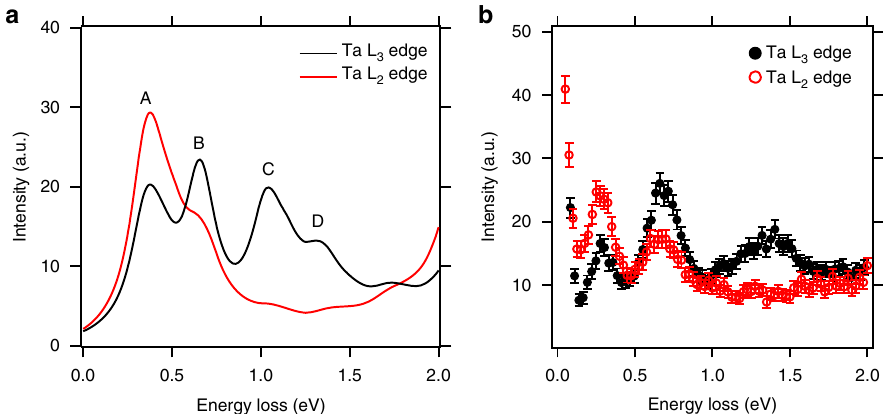
Fig. 5 Cluster model calculations of the L 3 and L 2 RIXS spectra. a RIXS spectra calculated within the fast collision approximation (zeroth order of the ultrashort core – hole lifetime expansion) and the dipole approximation using the model parameters U = 2 eV, λ SO = 0.4 eV, t σ = − 1.41 eV, t δ = 0.213 eV and t π = 0.1 eV. U and λ SO denote strengths of the on-site Coulomb repulsion and SOC, respectively, and t σ , δ ( t π ) denote diagonal (off-diagonal) nearest neighbor hoppings (see Supplementary Note 2). The spectral functions are convoluted with a Lorentzian function of 0.1 eV width. The lowest two peaks A and B are excitations from the fully occupied e and a 1 MO states, respectively, to the partially occupied J eff = 3/2 MO states. The excitation from the J eff = 3/2 MO states to the unoccupied J eff = 1/2 MO states is coincidently located at the second peak B. The excitations from the e and a 1 MO states to the J eff = 1/2 MO states are well separated and comprise the higher two peaks C and D, respectively. The latter three excitations involving the J eff = 1/2 MO states are absent in the L 2 -edge RIXS spectrum. b The corresponding experimental RIXS spectra at L 3 - and L 2 -edge with error bars . The error bars indicate the standard deviation to the number of detected